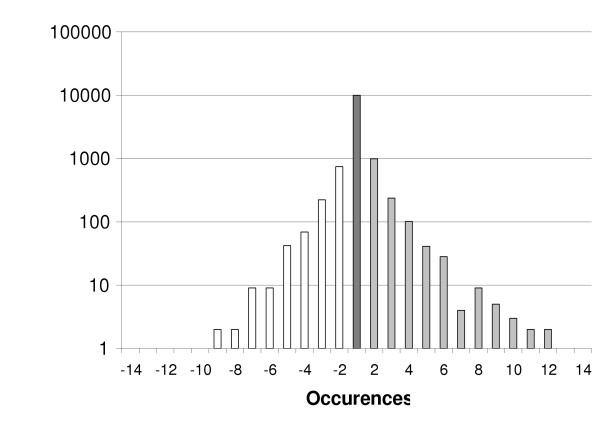
Summary of the SAGE data. The ratio of the number of occurrences for each given unique tag in both libraries (UN (-) and UN (+)) has been calculated. Tags have been grouped according to their expression ratio (X-Axis). The frequency (Y-Axis) plot of this ratio shows a Gaussian distribution.